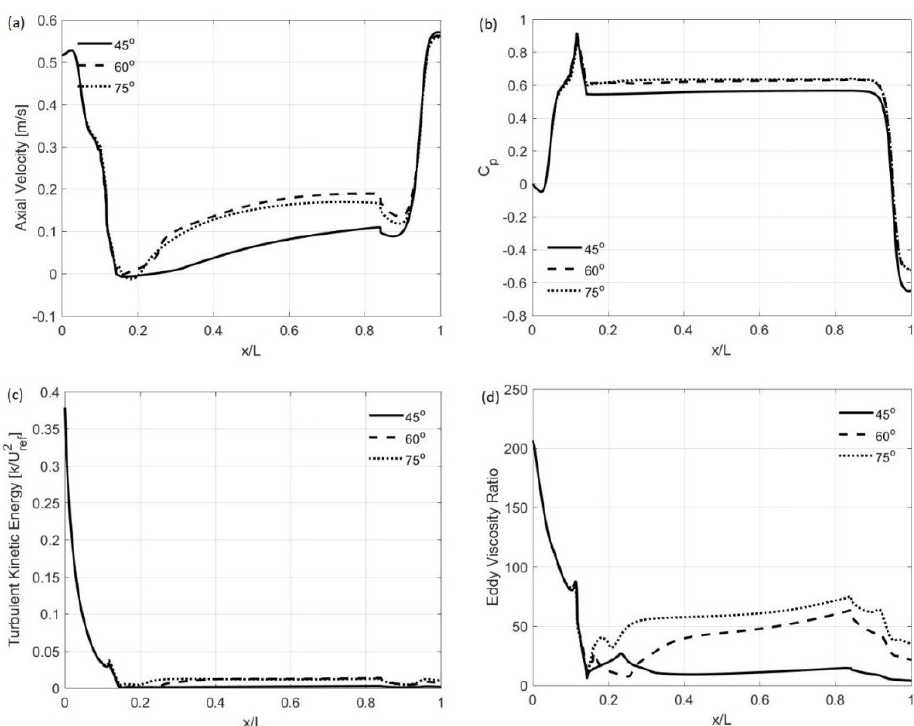
Figure 4. Predicted variation along the reactor centerline of the mean axial mean velocity ( a ), the pressure coefficient ( b ), the turbulence kinetic energy ( c ), and the eddy-viscosity ratio ( d ). Results are plotted for three different values of blade pitch.